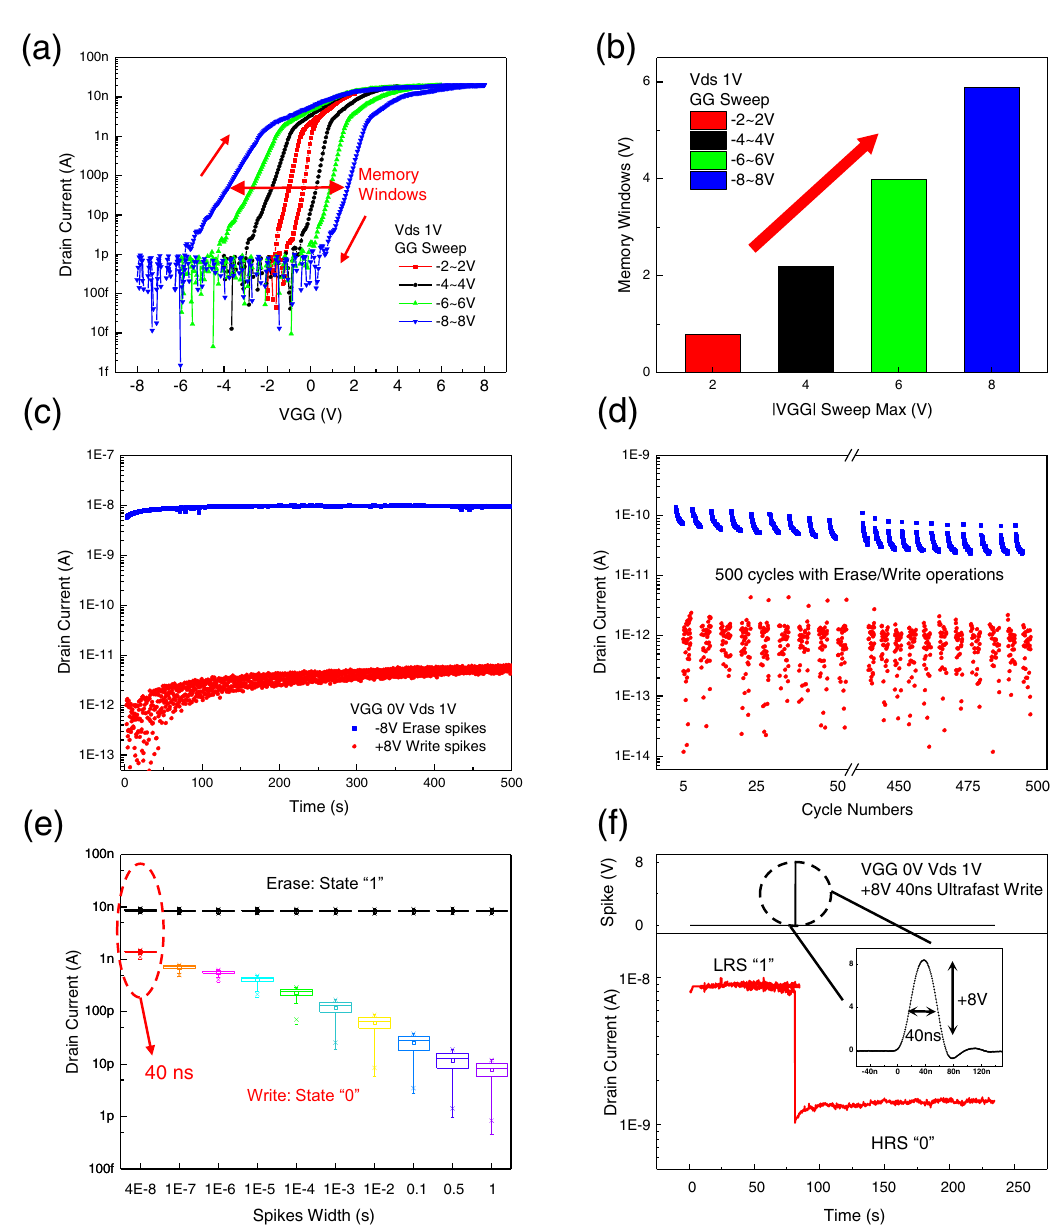
Fig. 3 2D α -In 2 Se 3 FeCTs for NVM with ultrafast writing. a Transfer curves of 2D FeCTs NVM, where the clockwise hysteresis windows expand with increasing VGG, showing cumulative channel polarization. b The memory window extracted in (a) is incremented to get a maximum of 6 V. c NVM retention characteristics, with suf fi cient GG write and erase spikes (±8 V, 10 s and read at VGG = 0 V, Vds = 1 V), LRS/HRS ratio exceed 10 3 . d The robust endurance of α -In 2 Se 3 FeCTs NVM after 500 erase and write cycles, showing negligible degradation of HRS and LRS. e FeCTs NVM programming speed with fi xed LRS. LRS/HRS ratio decreases with the decrease of the writing width, and even 40 ns can implement effective writing, which may be attributed to the ultra-fast ferroelectric switching. f Under the action of a 40 ns ( + 8 V) write spike, the channel current transitions from the initial LRS “ 1 ” to HRS “ 0 ” and shows non-volatile data retention, which con fi rms the ultrafast programmability of 2D α -In 2 Se 3 FeCTs NVM. The inset is an actual waveform of 40 ns ultrafast write